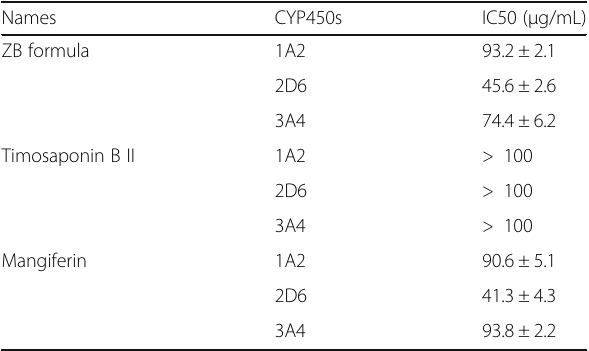
Table 5 Effects of BZ formula and its main components timosaponin BII and mangiferin on P450 activity in rat liver